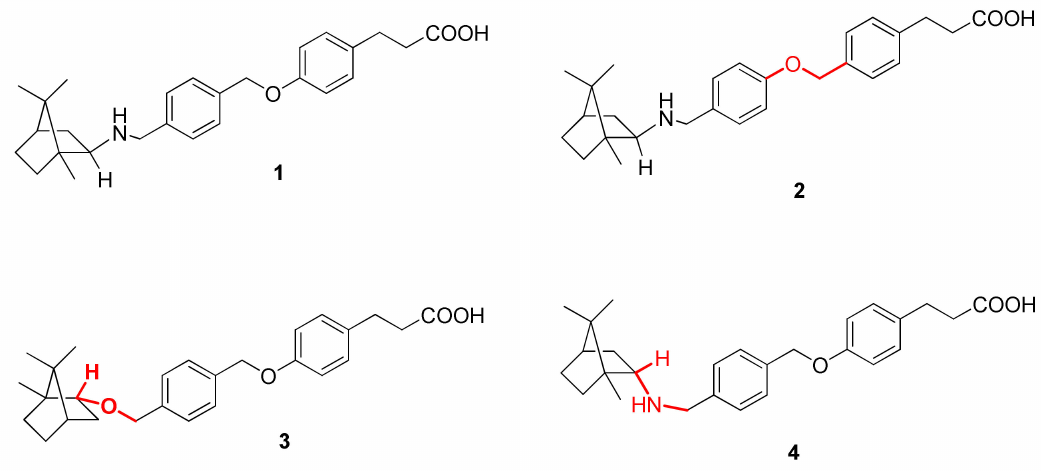
Figure 1. New bornyl